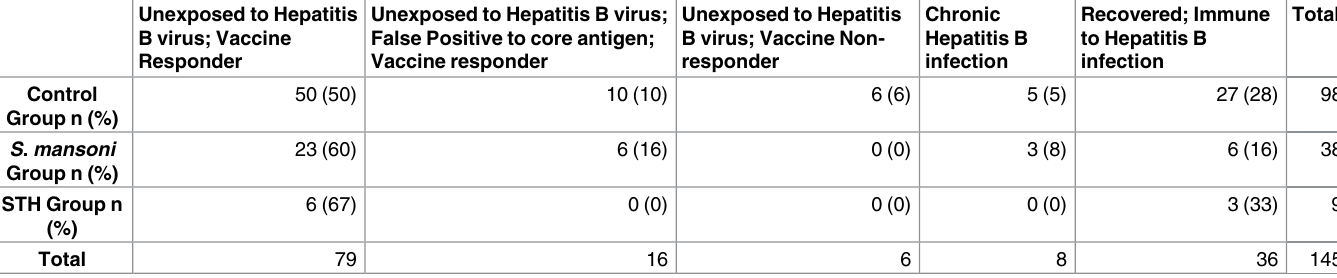
Table 2. Percentage of participants falling into the catagoriesfor hepatitis B virus